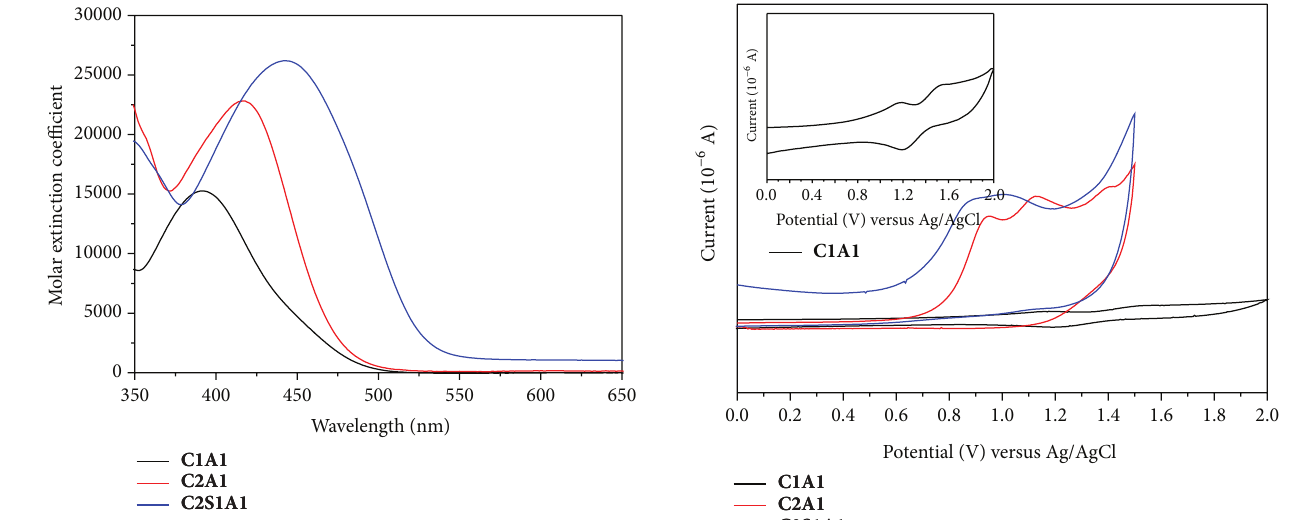
containing 0.1M TBAPF 6 as supporting electrolyte at a scan rate of 50 mVs −1